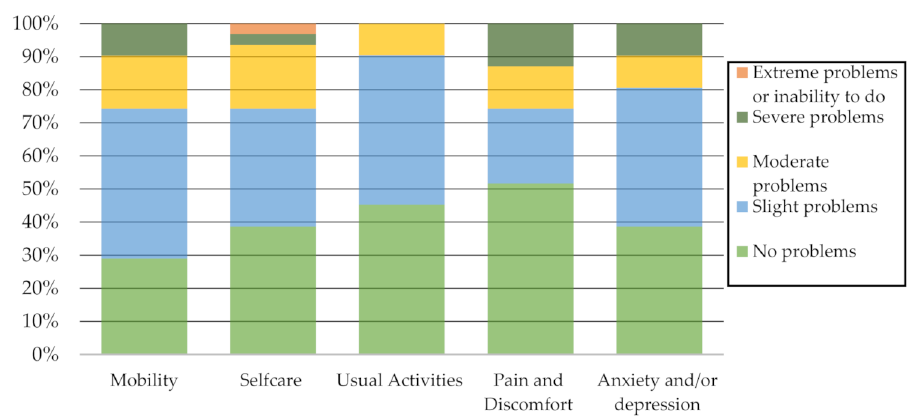
Figure 2. EQ-5D-5L Descriptive system dimensions.